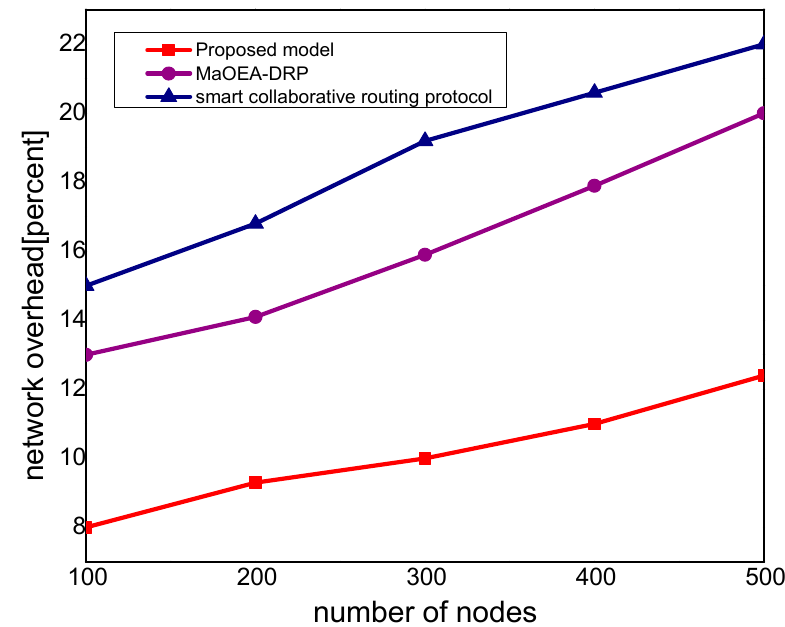
Figure 4. Network overhead with the number of nodes.